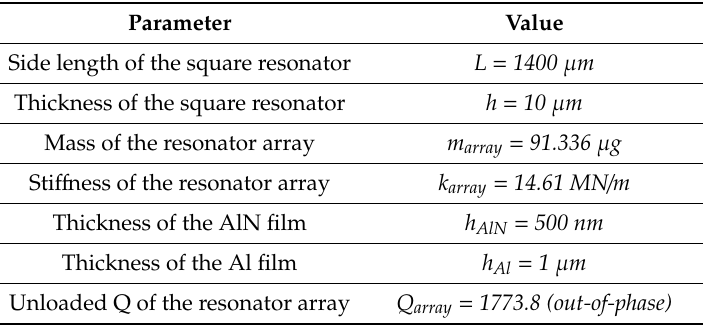
Table 1. Dimensions of the weakly coupled MEMS